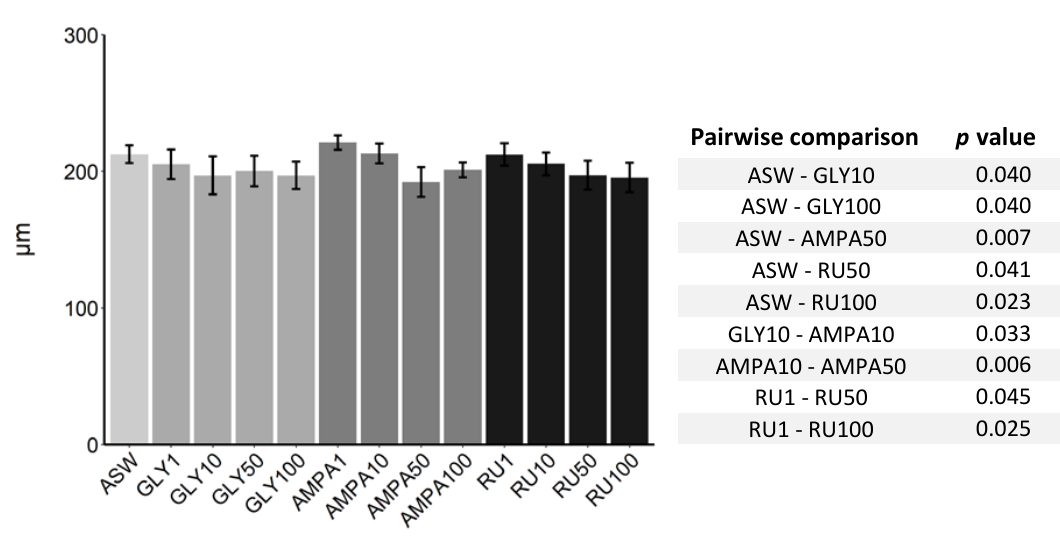
Figure 5. Somatic rod length in sea urchin larvae reared in control conditions (ASW) and in four concentrations (1, 10, 50, 100 µ g / L) of three contaminants: glyphosate (GLY), AMPA and Roundup (RU). Values are means ± s.e., n = 6–9. Statistically significant pairwise comparisons are reported in the table on the right.